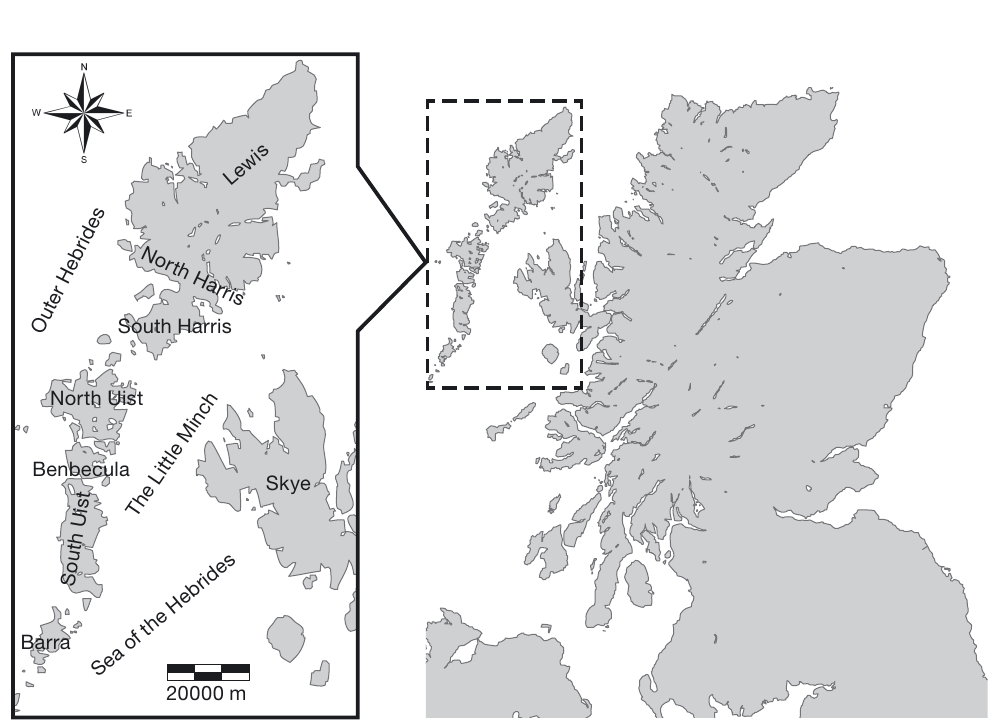
Fig. 1. The Western Isles off the North West coast of Scotland, UK. Latitude 57.60°N, longitude